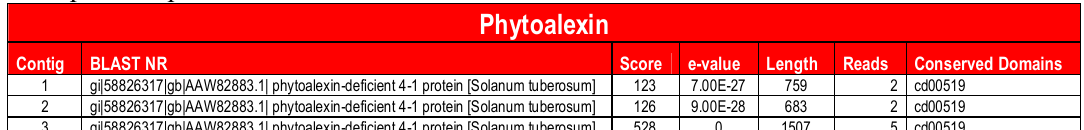
Table S10: EST-Contigs with e-value < e -20 and score > 100 obtained in the Project Phytoalexin, and their blast hit, score, e-value, size, number of reads, and conserved domains from putative